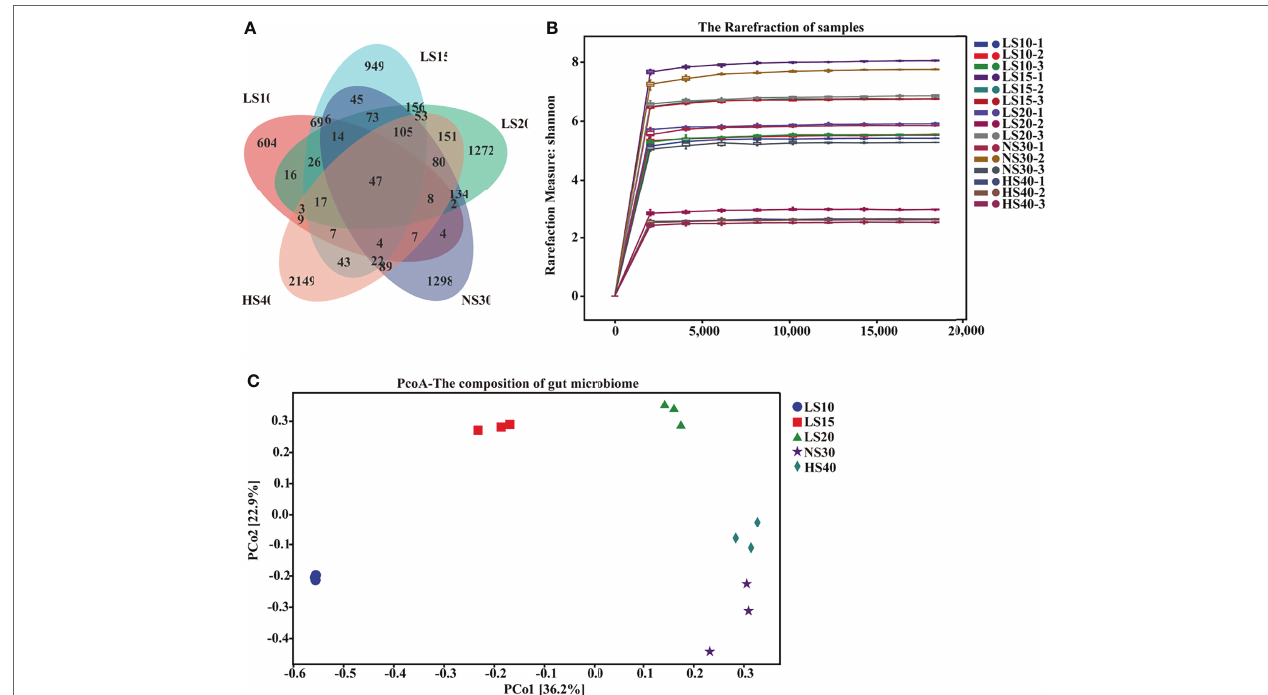
FIGURE 4 | Changes in diversity of U. unicinctus intestine microbial species upon salinity stress. (A) Venn diagram of OTUs detected in the gut of 10‰ (LS10), 15‰ (LS15), 20‰ (LS20), 30‰ (NS30) and 40‰ (HS40) salinity. Different colors represent different groups. (B) Rarefaction curves of different salinity groups based on the Shannon indices. (C) Principal coordinate analysis (PCoA) of different salinity groups based on the Bray-Curtis